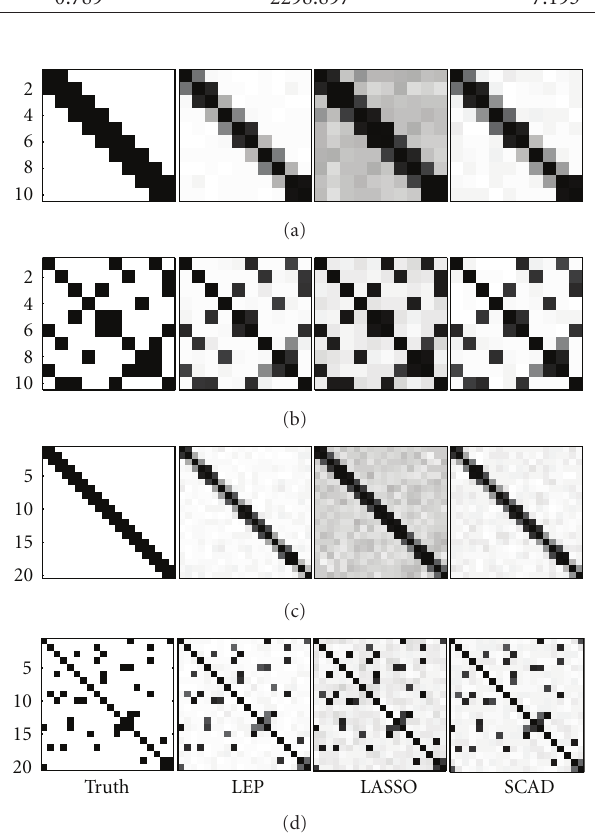
Figure 1: The relative frequency matrices in four scenarios of the simulation studies. The first, second, third and forth rows corres- pond to scenario 1, 2, 3 and 4,